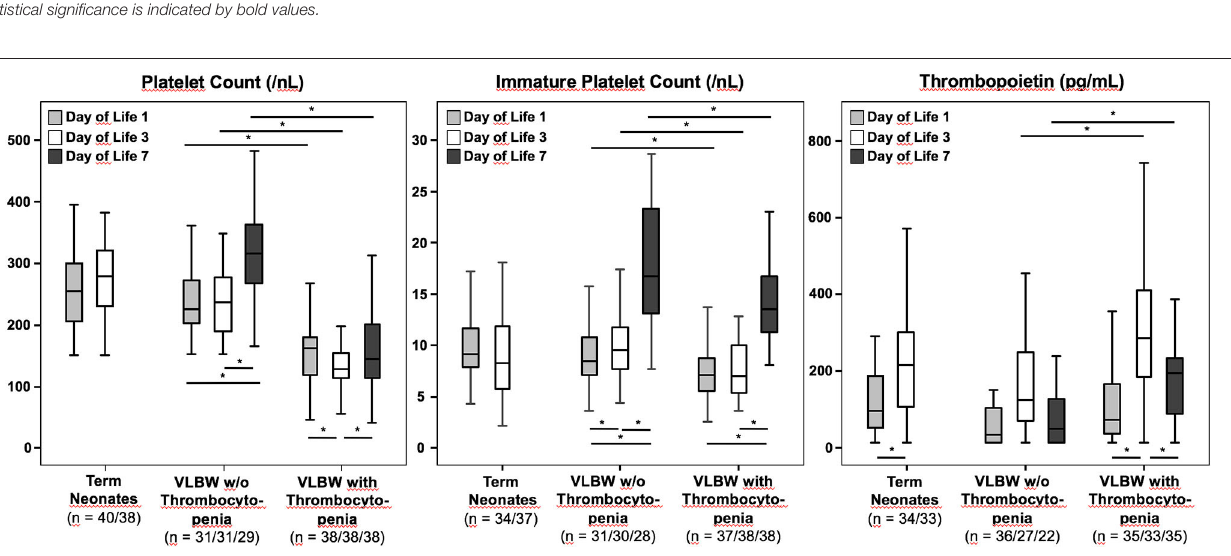
VLBW infants with thrombocytopenia